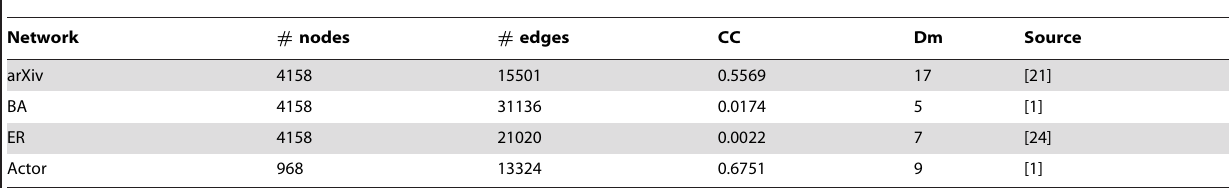
Table 1. Summary of networks studied.